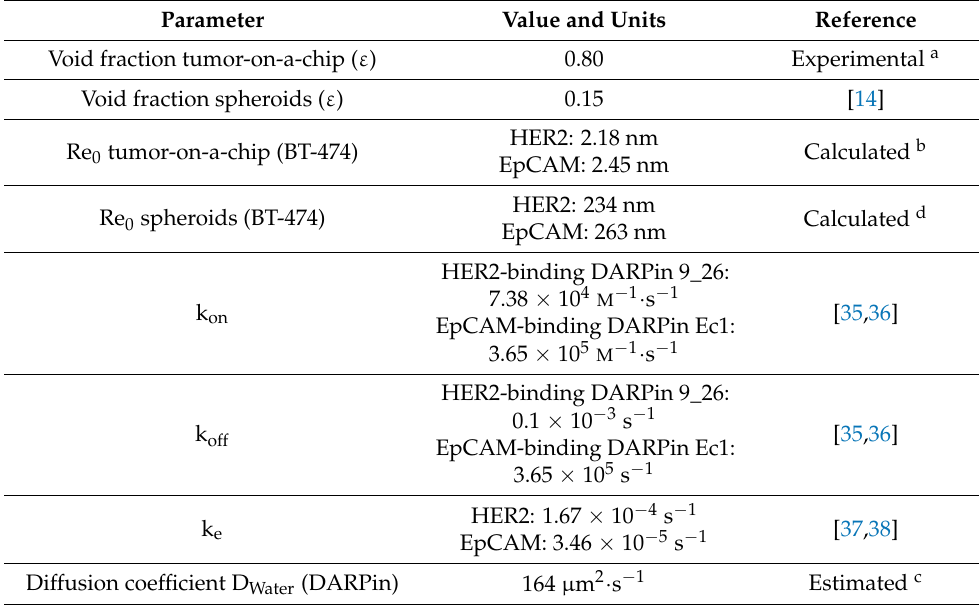
Table 1. Parameters used in the mathematical model for describing protein delivery in multicellular tumor spheroids and in a microfluidic